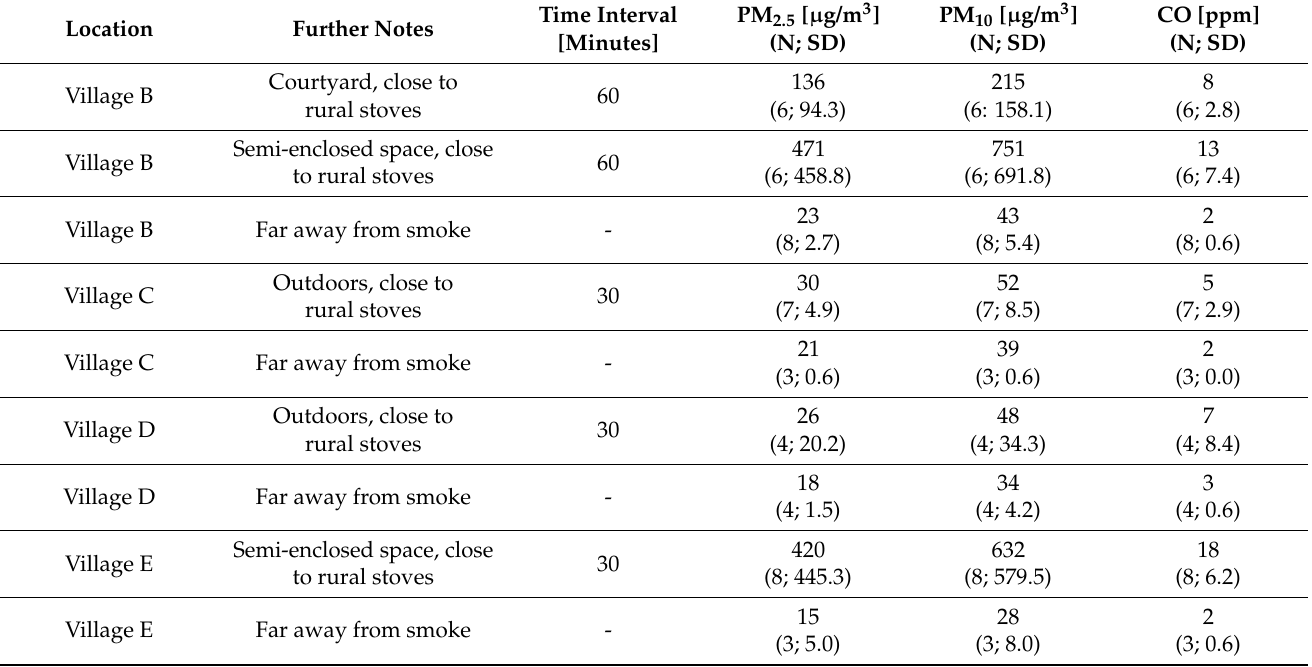
Table 2. Average concentrations of PM 2.5 , PM 10 , and